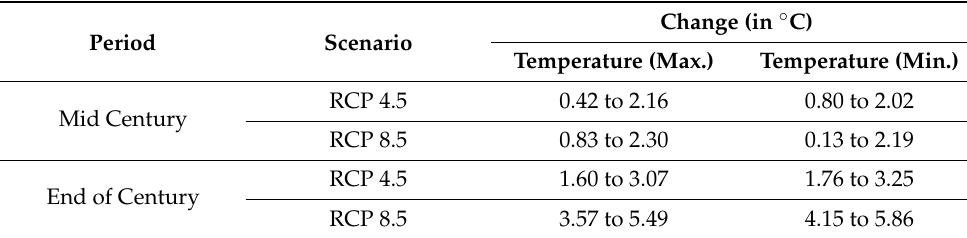
Figure 11. The variability of projected average annual maximum and minimum temperatures for the multimodel ensemble RCM (RCP 4.5 and RCP 8.5) in EC. Table 4. The Range of change in the projected seasonal maximum and minimum temperatures concerning the historical